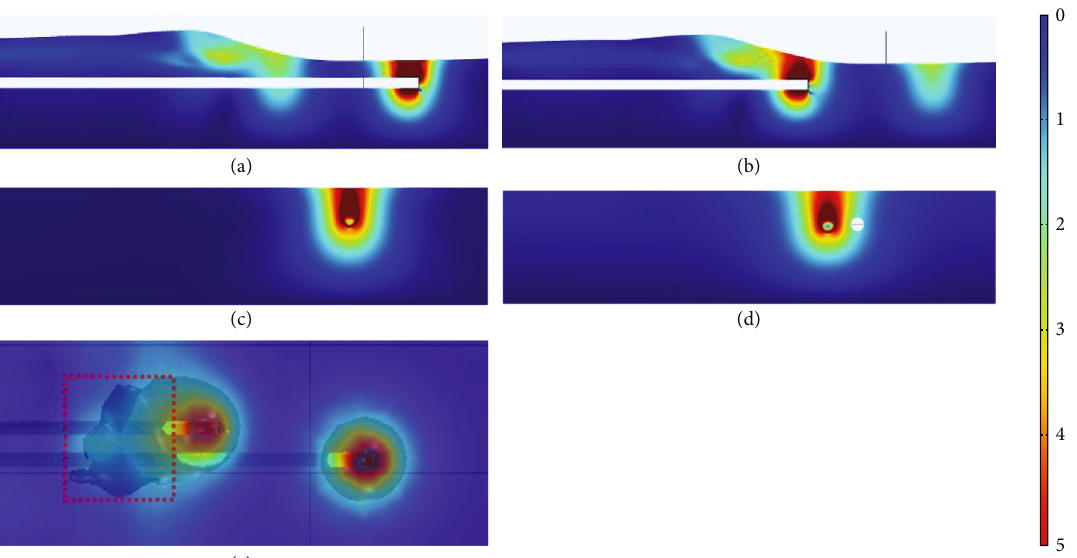
Figure 12: Displacement diagram of model calculation results for both shields crossing the fl ood control levee: (a) longitudinal section of the right line tunnel; (b) longitudinal section of the left line tunnel; (c) cross-section of the right line tunnel palm face; (d) cross-section of the left line tunnel palm face; (e) top view of the tunnel model